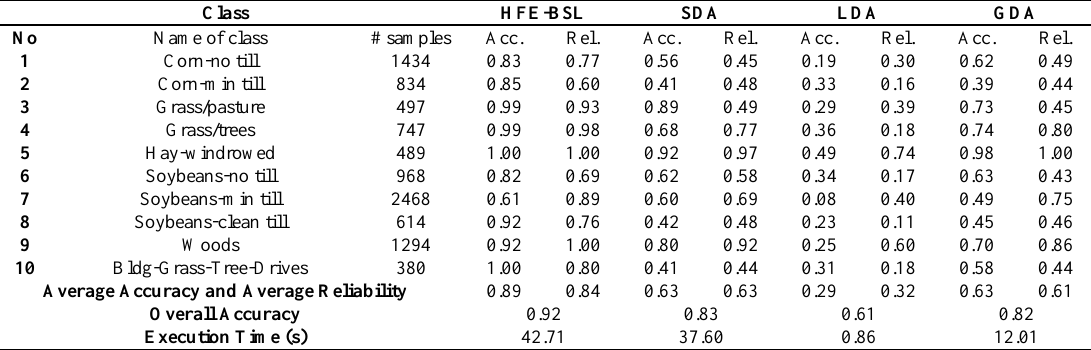
Table 1. Accuracies and reliabilities obtained for each class of Indian dataset using 9 extracted features and 16 training samples.